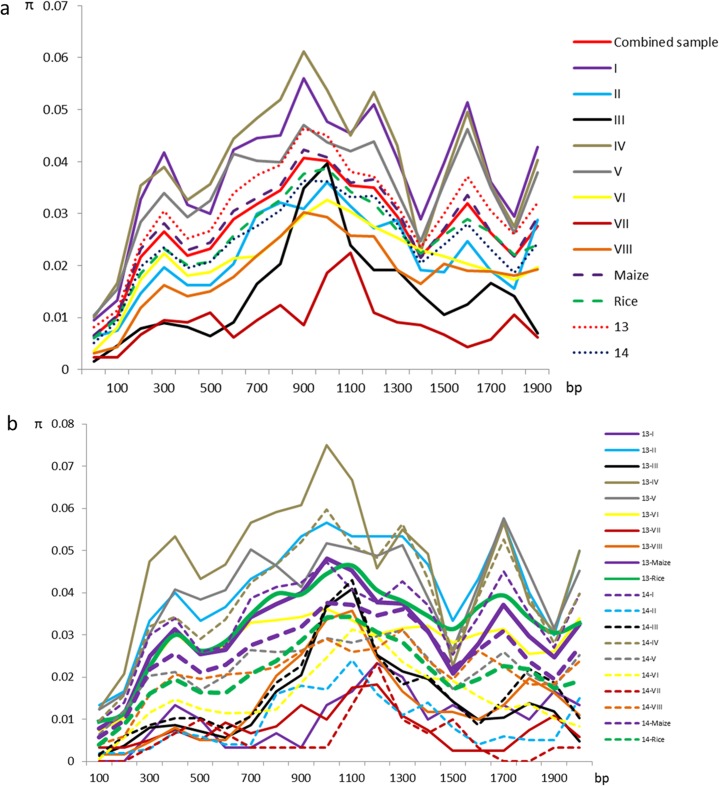
Sliding-window analysis of the nucleotide diversity in S7 sequences across Chinese isolates.(a) Sliding-window analysis of nucleotide diversity in S7 sequences calculated using a 200-bp window and 100-bp steps including combined isolates, or 111 individual Chinese isolates. I, sampled from Beijing; II, sampled from Tangshan, Hebei Province; III, sampled from Baoding, Hebei Province; IV, sampled from Jinan, Shandong Province; V, sampled from Jining, Shandong Province; VI, sampled from Zhengzhou, Henan Province; VII, sampled from Yancheng, Jiangsu Province; VIII, sampled from Nanjing, Jiangsu Province. Maize, isolates from maize hosts from eight geographic locations; Rice, isolates from rice hosts from four locations. (b) Sliding-window analysis of nucleotide diversity in S7 sequences calculated for data from two years.